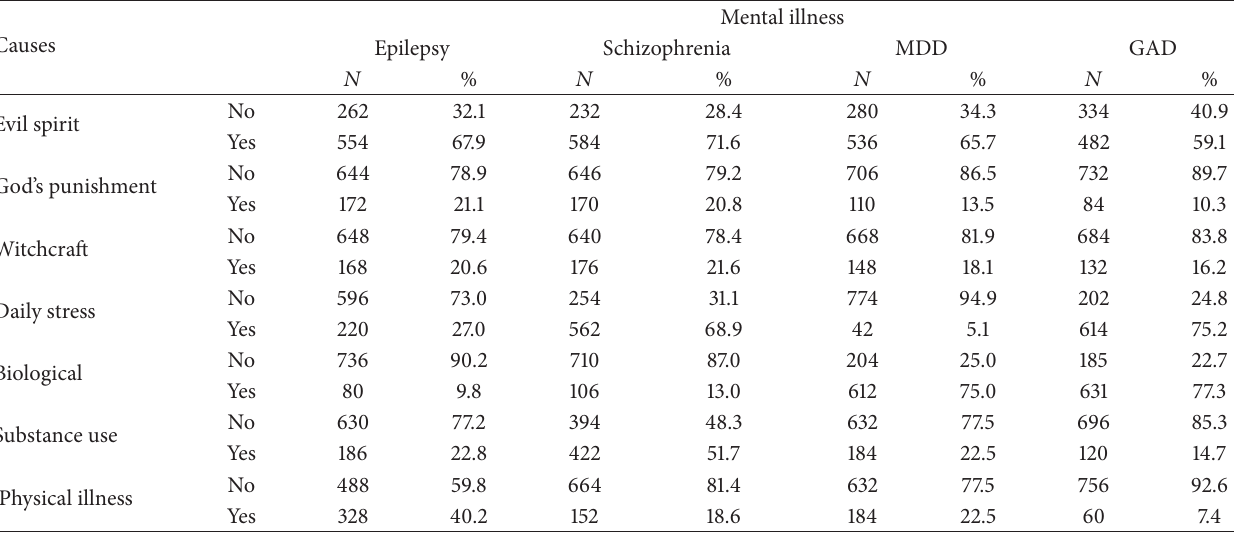
Table 3: Distribution of respondents’ perceived cause of mental illness among residents of Gimbi town, West Wellega Zone, Oromia region, Ethiopia (multiple responses), 2014.